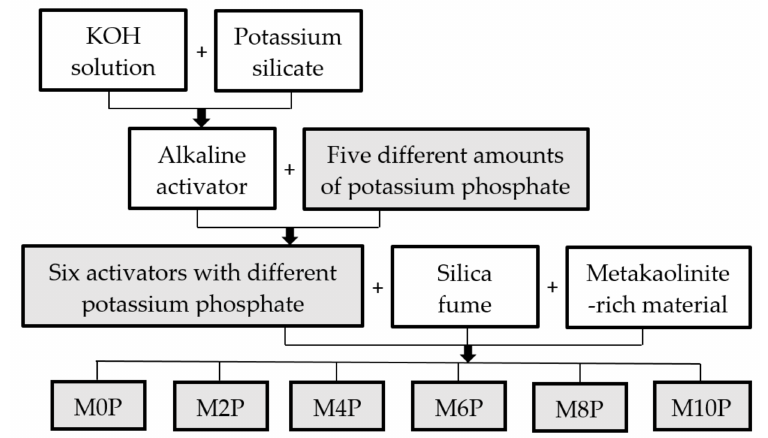
Figure 2. Scheme of six matrices preparation.